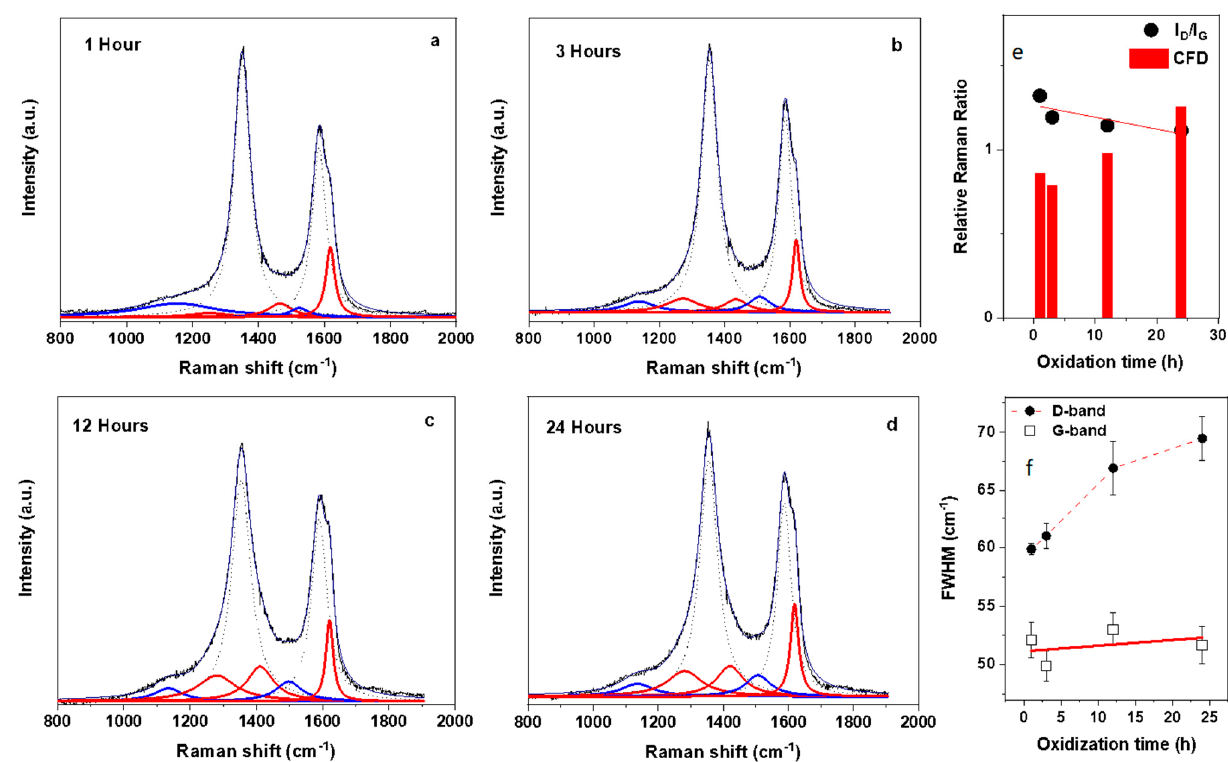
Figure 2. Raman spectroscopy used to evaluate the effect of extended time of oxidation. ( a – d ) The effect of oxidation time used to functionalize the MWNTs has a pronounced modification of the Raman spectrum, an increase in oxidation time results in the amplification of the satellite peaks relative to the main D and G modes. ( e ) The I D /I G ratio is conventionally used to evaluate levels of disorder in graphitic type materials but does not capture the full effect of increasing functionalization. The ratio here shows a linear decrease with increasing oxidation time whereas evaluation of the effective area of the deconvoluted peaks is more sensitive to the variation in oxidation times and here shows a more pronounced rate of change than the I D /I G ratio. ( f ) The increase in the effective area of the satellite peaks is accompanied by an increase in the FWHM of both the G and D bands.